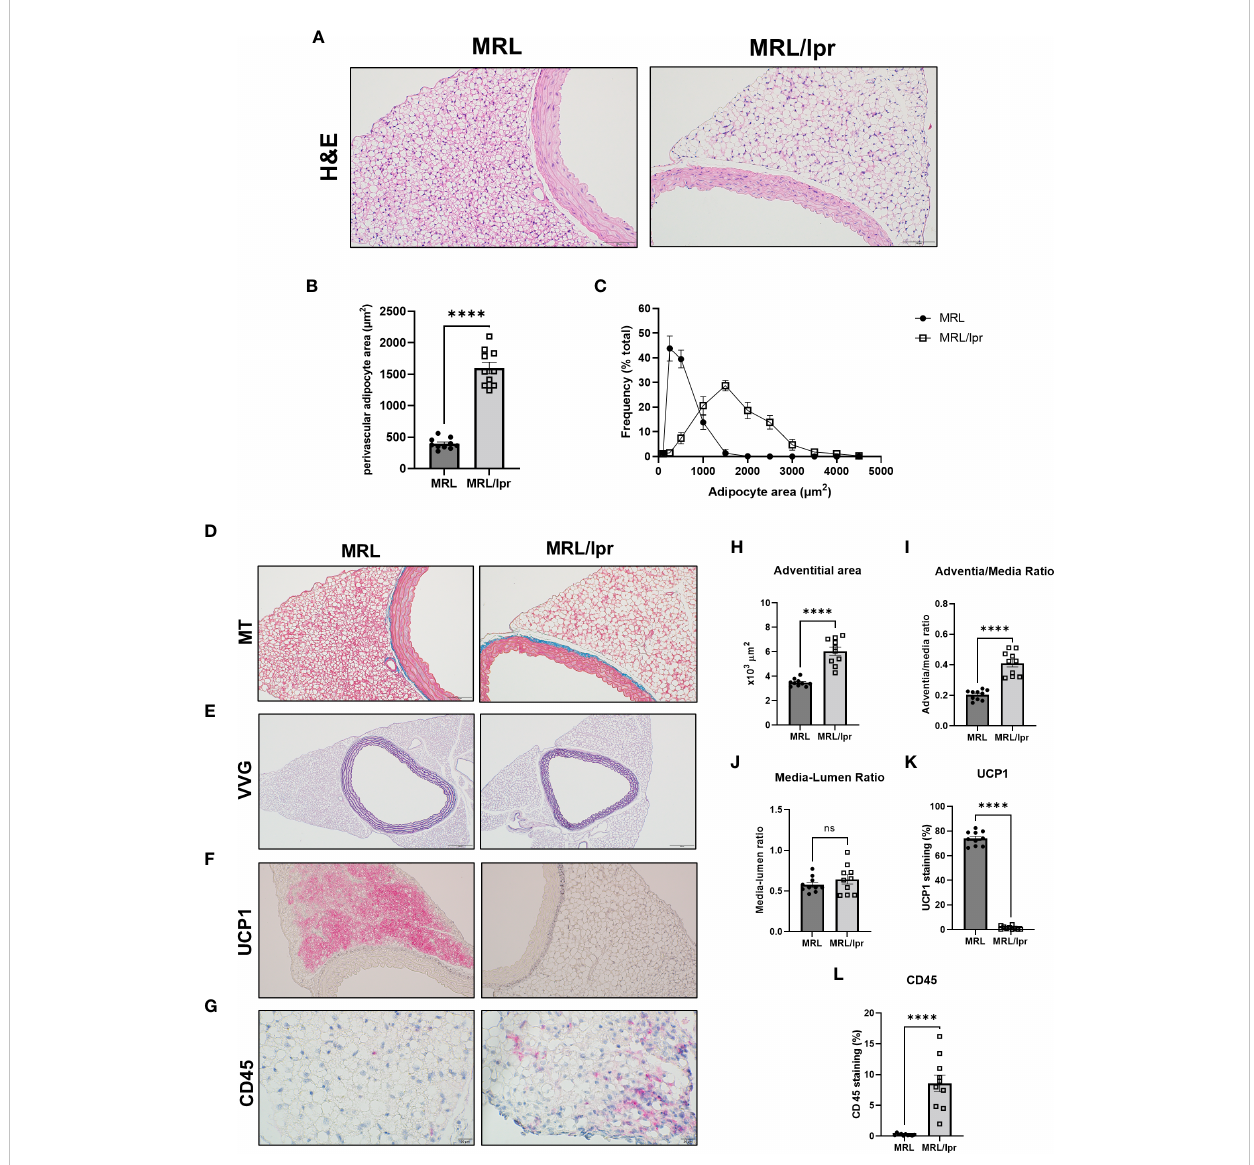
FIGURE 5 PVAT exhibited whitening and vascular remodeling in MRL/lpr mice. (A) Hematoxylin and eosin (H&E), scale bar=100 m m. (B) Quantitative analysis of average adipocyte size (area per adipocyte, m m 2 ); (C) the relative distribution of adipocytes calculated as frequency of adipocyte area (%) over total area. (D) Masson Trichrome (MT) staining for collagen, scale bar=100 m m; (E) Verhoeff-Van Gieson (VVG) staining for elastin, scale bar=200 m m; (F) UCP1 staining for beige adipocytes, scale bar=100 m m; (G) CD45 staining for leukocytes, scale bar=20 m m; and (H-L) quanti fi cation of adventitial areas, adventitia-media ratio, media-lumen ratio, percentage of positive UCP1 and CD45 areas. n=10. ****p < 0.0001 vs MRL (control). ns, not signi fi